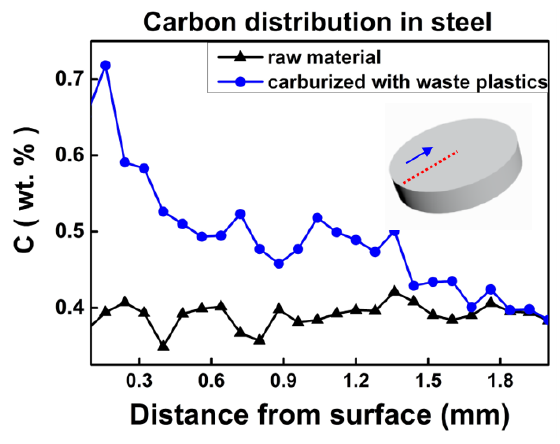
Figure 6. Detailed carbon concentration distribution in the reference steel sample and the as-carburized steel sample.